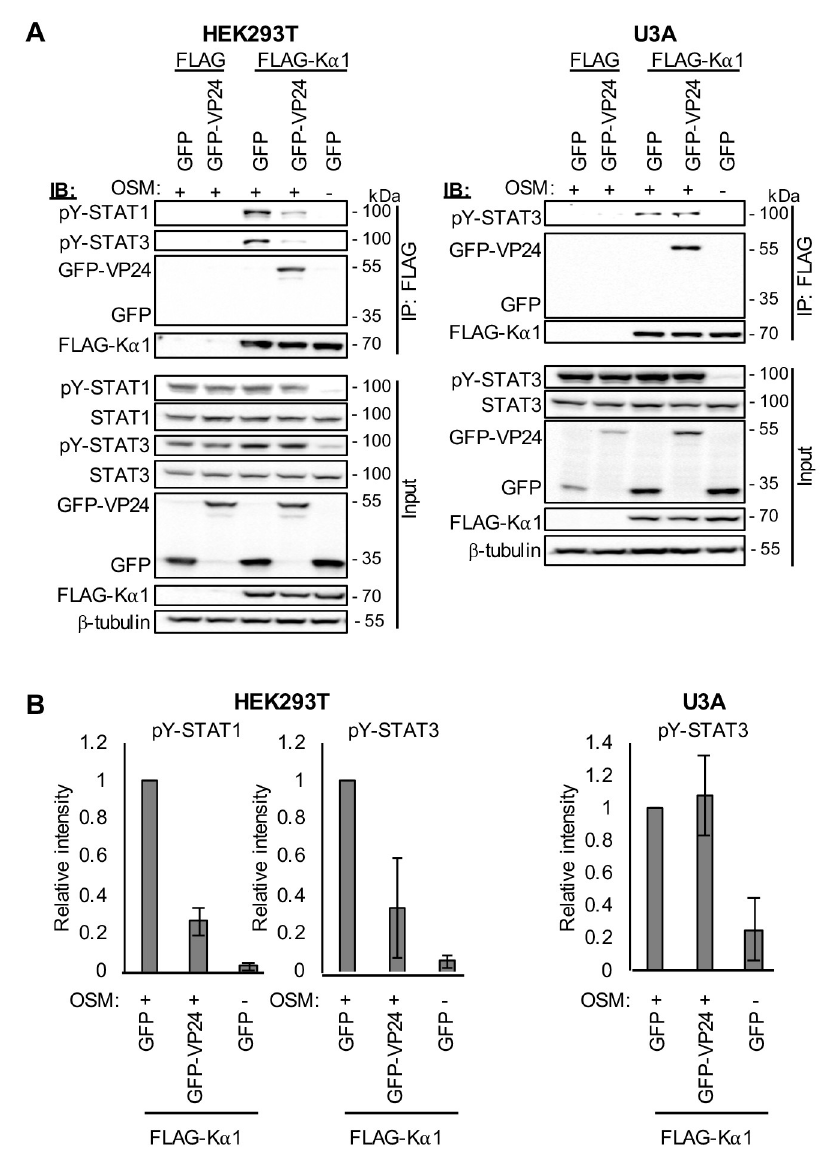
Fig 5. EBOV VP24 inhibits K α 1-STAT3 interaction, dependent on STAT1. (A) HEK293T or U3A cells co- transfected to express the indicated proteins were treated 24 h post-transfection with or without OSM (10 ng/ml, 15 min) before lysis and immunoprecipitation for FLAG. Lysates (input) and immunoprecipitates (IP) were analysed by IB using antibodies against the indicated proteins. Expanded images of all membranes are shown in S8 Fig. (B) Images of membranes such as those shown in (A) were analysed using Image Lab software to calculate the intensity of bands for pY-STAT1 and pY-STAT3 in IP samples; values for the different samples were calculated relative to the intensity of the corresponding FLAG-K α 1 IP band and then normalised to control samples (FLAG-K α 1/GFP treated with OSM); the histograms show mean ± SD, n � 2 assays. to DNA, similar to the antagonistic mechanism of RABV P-protein for STAT1, where the P- protein binds proximal to or within the STAT1 DNA binding domain [44,45]. To assess DNA binding by STAT3, we performed electrophoretic mobility shift assay (EMSA) analysis of cell lysates using the m67 probe (Fig 6), which is a high affinity variant of the sis-inducible element